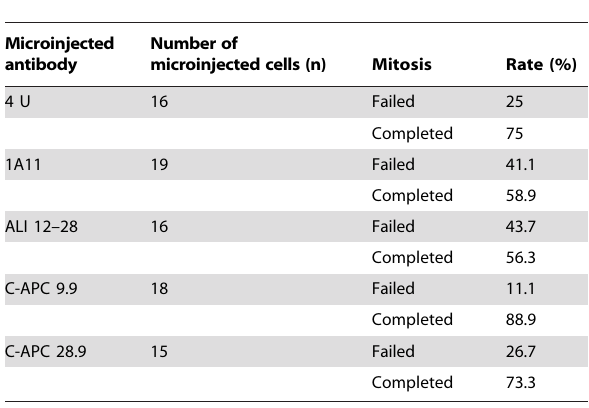
Table 1. Mitotic success rates following